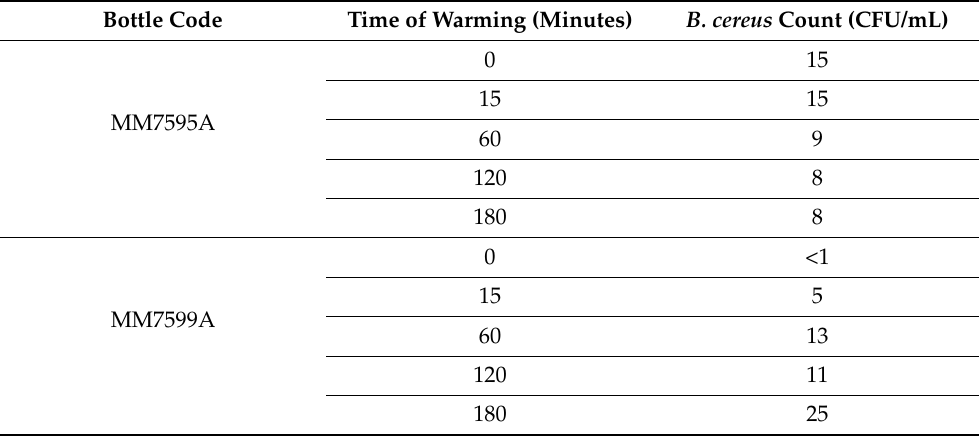
Table 2. Changes of B. cereus counts in thawed PBM during warming.